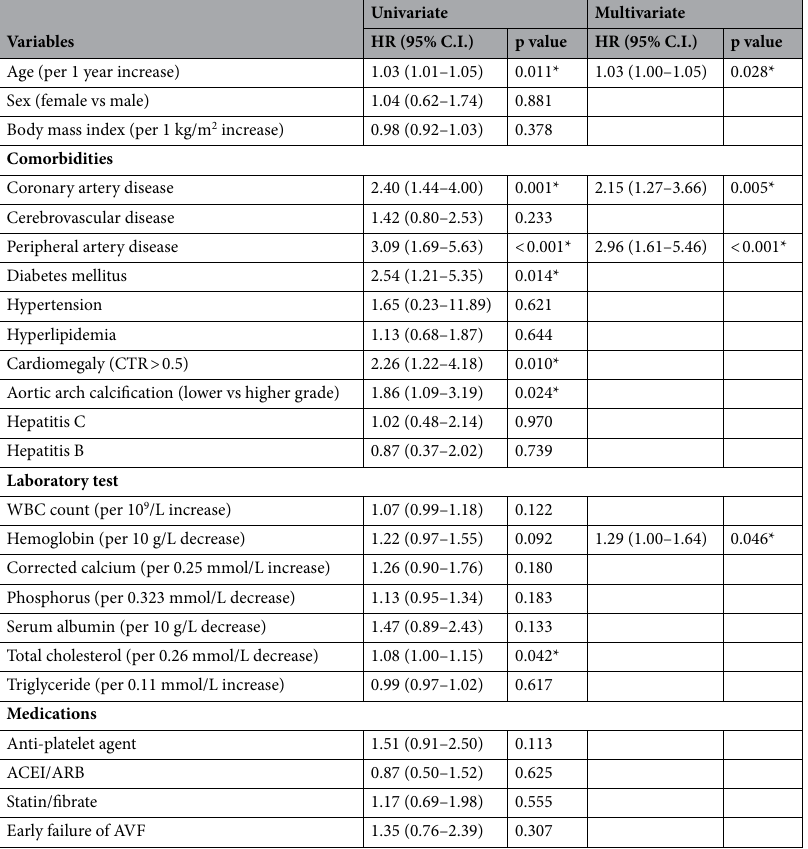
Table 3. Associated factors of cardiovascular mortality among study patients by using Cox proportional hazards analysis. CTR cardiothoracic ratio, WBC white blood cell, ACEI angiotensin converting enzyme inhibitor, ARB angiotensin receptor blocker, AVF arteriovenous fistula. *p <